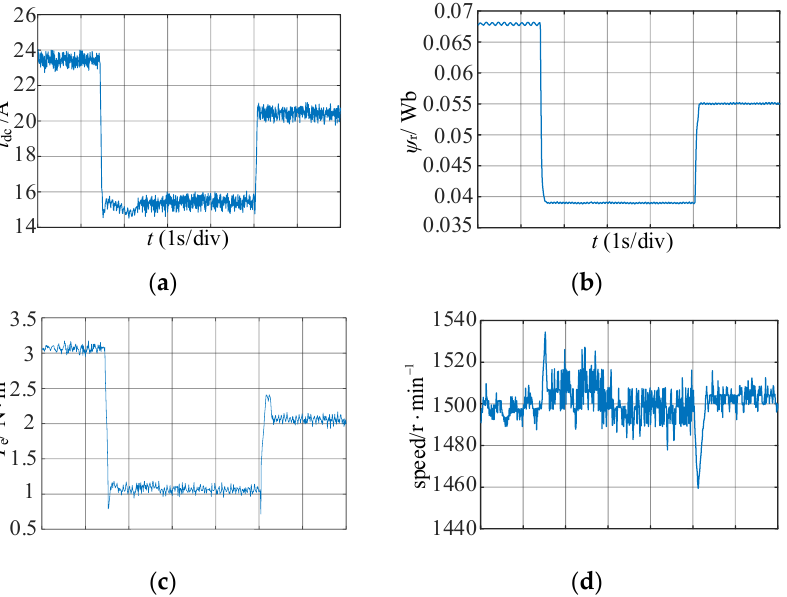
Figure 23. Experimental waveforms under different loads: ( a ) DC − link current; ( b ) Rotor flux; ( c ) Torque; ( d ) Speed.